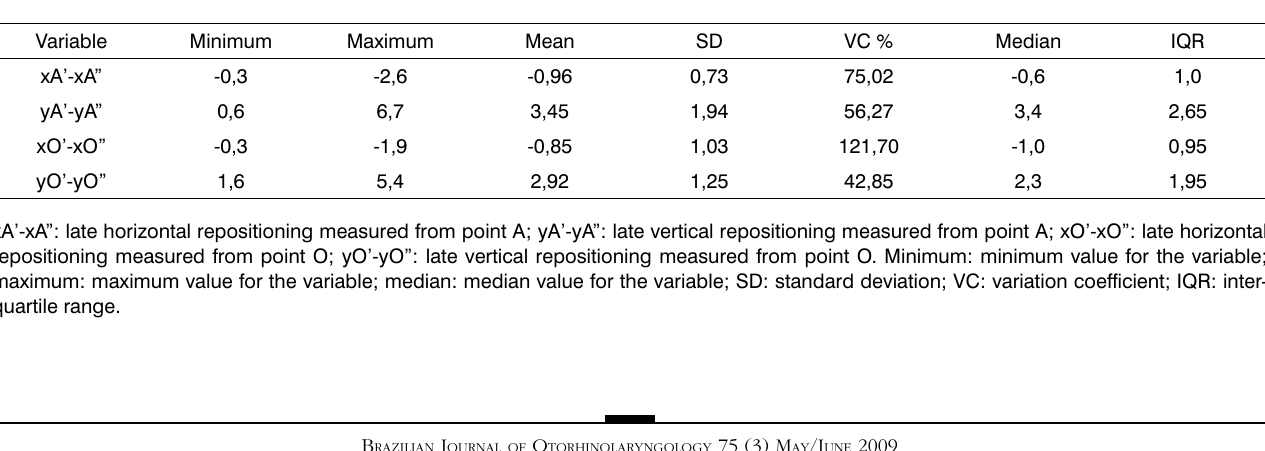
Table 2. Correlation among variables found in measurements from point A and the orbit point, in preoperative and early postoperative tracings. Variables r p A-xA’ 0,82 A-yA’ O-yO’ 0,89 A-A O-O’ 0,72 0,0001* Spearman’s correlation coefficient (r) for the variables A-xA’ and O-xO’; A-yA’ and O-yO’; A-A’ and O-O’. A-xA’: horizontal advancement mea- sured from point A; A-yA’: vertical displacement measured from point A; A-A’: resulting movement vector measured from point A; O-xO’: horizontal advancement measured from point O; O-yO’: vertical dis- placement measured from point O; O-O’: resulting movement vector measured from point O. (p: descriptive level test of r being equal to zero hypothesis); *: statistically significant.